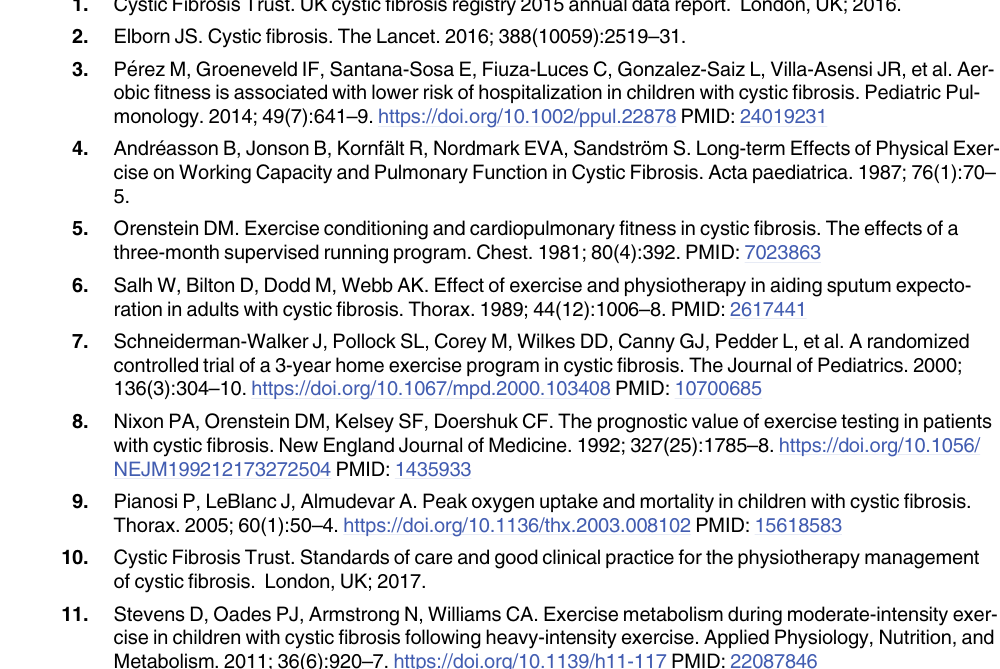
Table A : Parameter values. Table B : Calculated values of _ V ventilatory dead-space. Table C : Definitions of model parameters.